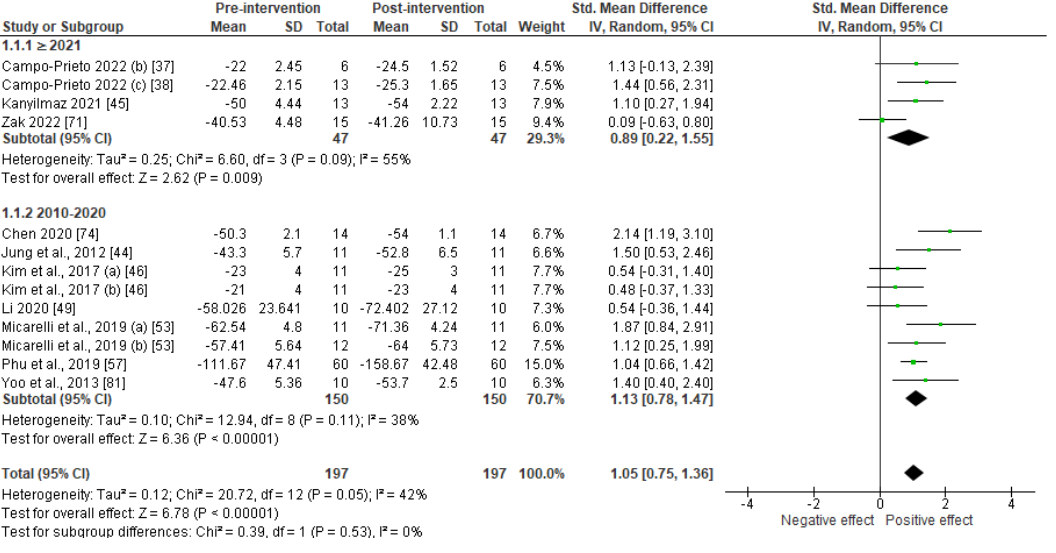
Figure 3. Forest plot of effects of intervention using immersive technologies on gait speed.